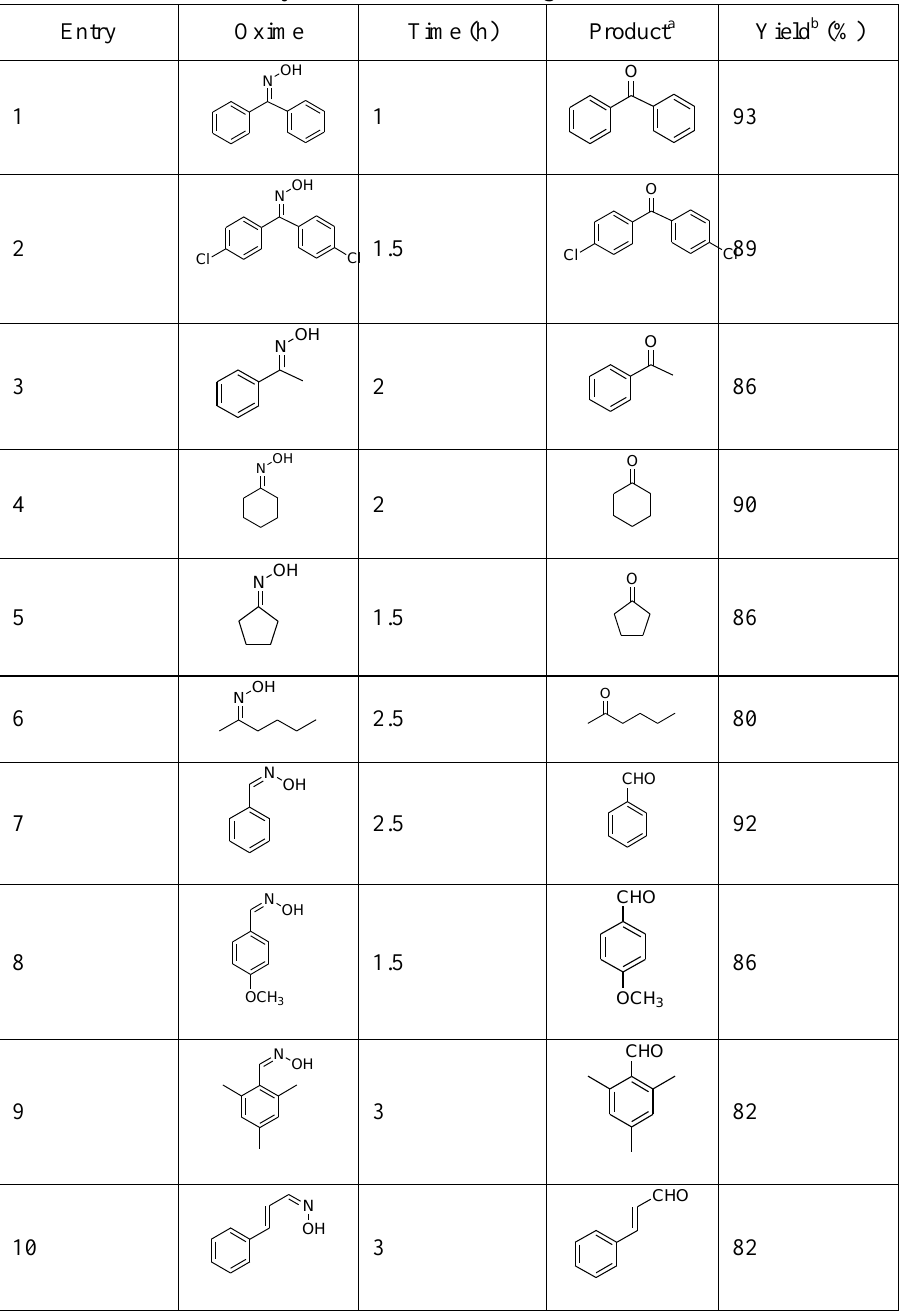
Table 1. Oxidative cleavage of oximes to their corresponding carbonyl compounds with potassium dichromate-dimethyl formamide under homogeneous